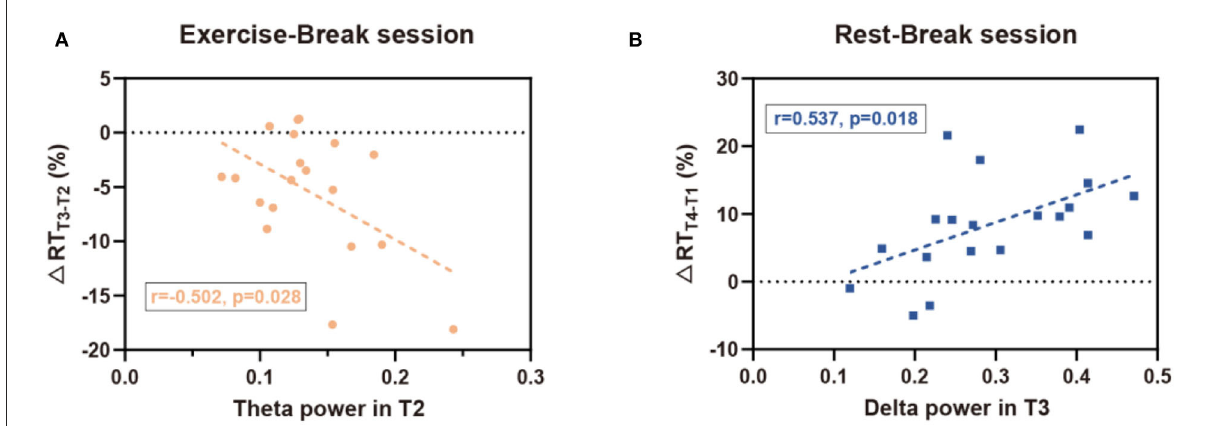
FIGURE7 Correlation results for EEG-behavior analysis. (A) In the Exercise-Break session, RT change (in percentage) from T2 to T3 was negatively correlated with EEG theta power in T2. (B) In the Rest-Break session, RT change (in percentage) from T1 to T4 was positively correlated with EEG delta power in